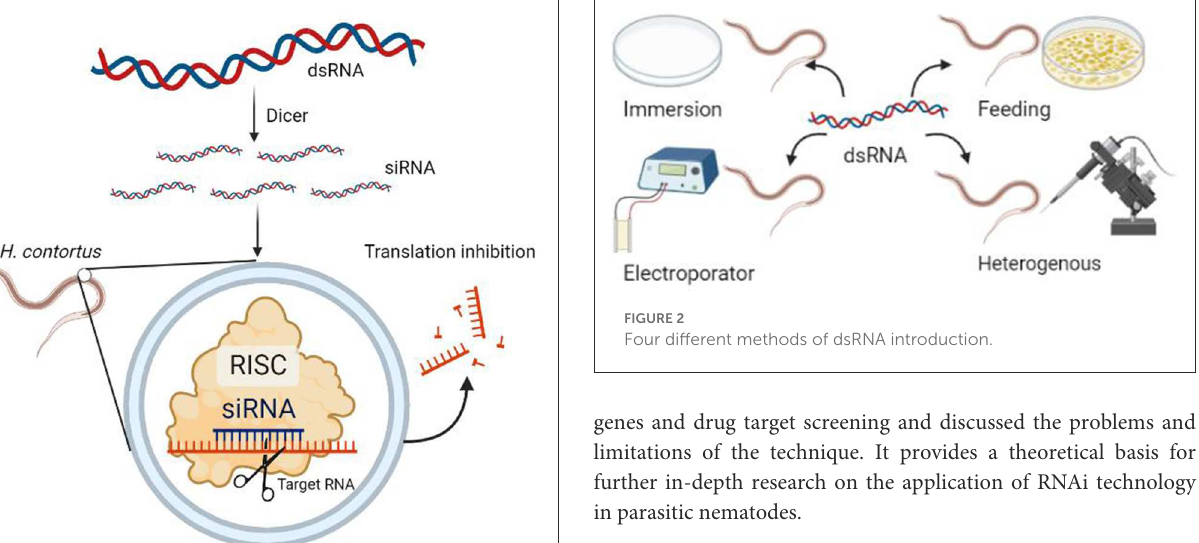
FIGURE1 RNAi principle.